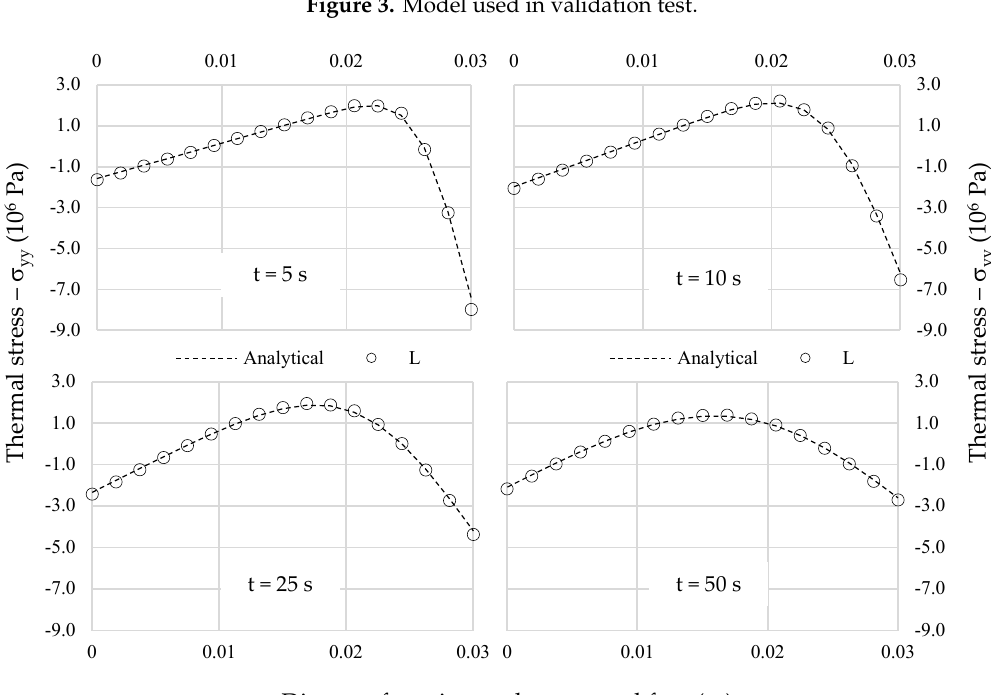
Figure 4. Comparison between analytical and numerical (linear) solution for several elapsed times. (t = 5 s, t = 10 s, t = 25 s, t = 50 s).